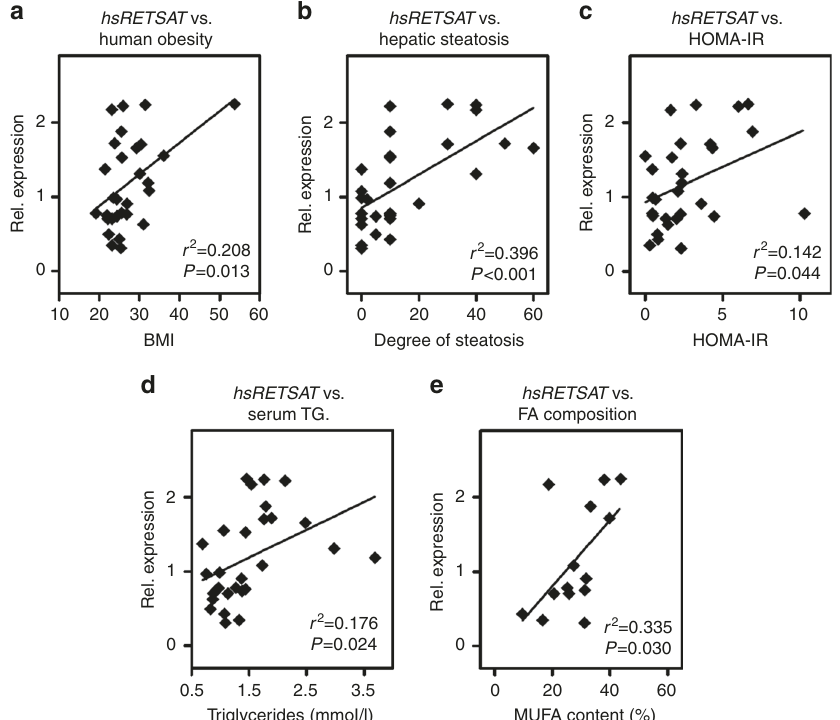
Fig. 3 Hepatic RetSat expression in humans correlates with obesity and liver steatosis. RETSAT mRNA expression in human liver samples was determined by qPCR ( n = 29) and correlated with a patient body mass index, b degree of hepatic steatosis, c HOMA-IR and d serum TG. e In a subset of 14 liver samples, MUFA content was determined and correlated with the expression of RETSAT . Normality of data was assessed by the Kolmogorov – Smirnov test and, depending on data distribution, signi fi cance was determined by Pearson a , c – e or Spearman b correlation coef fi